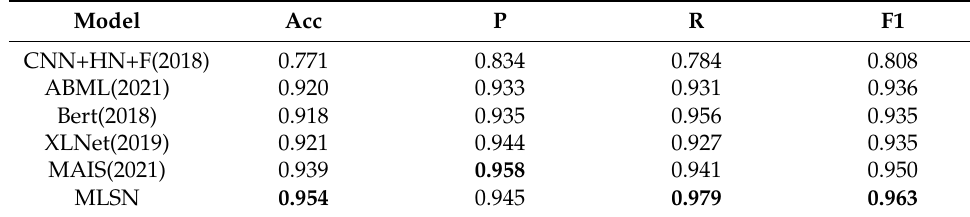
Table 4. Evaluation results of each model on SemEval-2021 Task 7